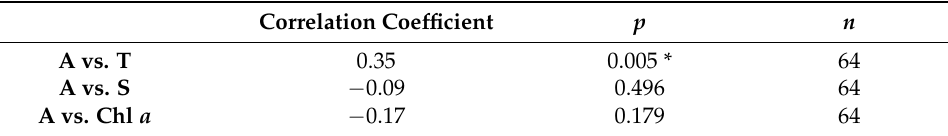
Figure 5. Dolioletta gegenbauri. Size (mm) frequency distribution of each life stage in October 2020 in the Jiaozhou Bay. ( a ) Gonozooids. ( b ) Phorozooids. ( c ) Nurse zooids. Normal distribution curve fit is indicated in each panel. Table 2. Pearson correlations between log 10 abundance (zooids m − 3 ) of Dolioletta gegenbauri and temperature (°C), salinity, and surface Chl a concentration (ug L − 1 ). A, abundance; T, temperature; S, salinity. ‘*’ indicates the statistical significance ( p <